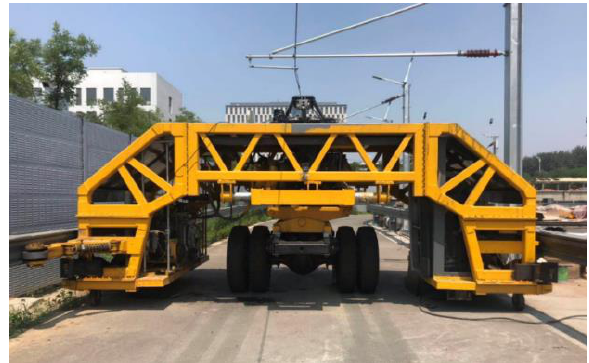
Figure 4. Full-scale accelerated loading test system.